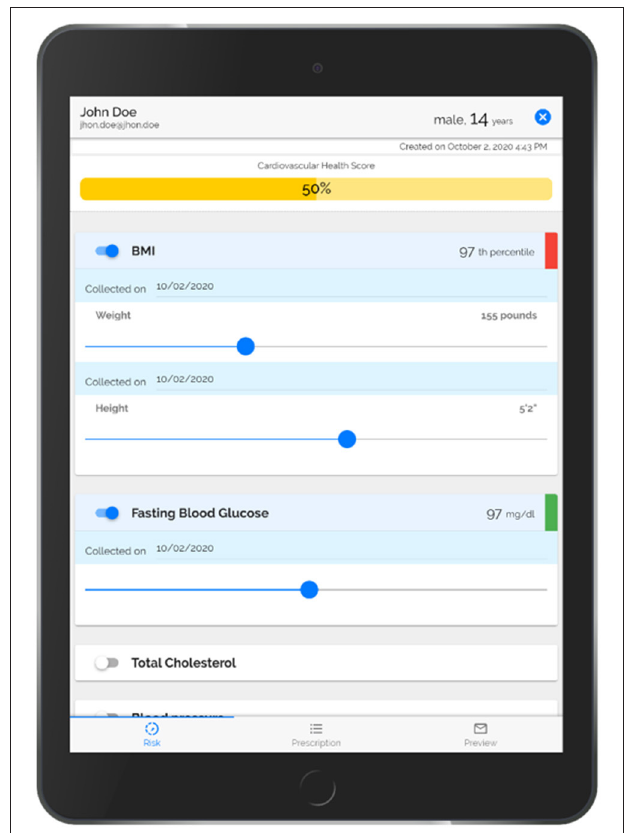
FIGURE 3 | PREVENT tool step 1, discuss prevention and cardiovascular